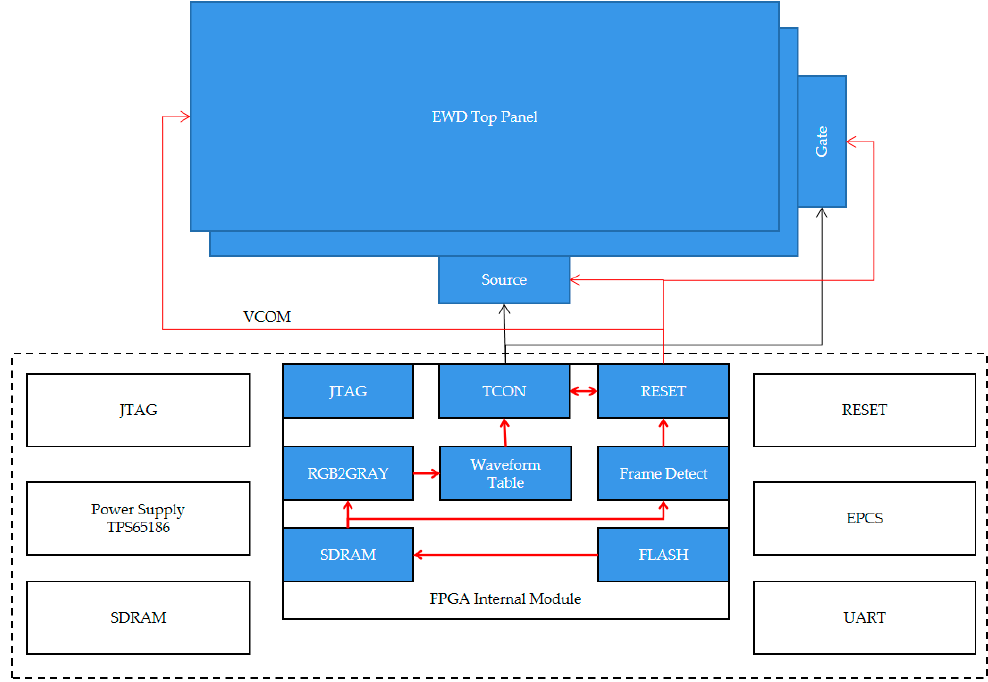
Figure 5. The block diagram of the driving board and the function module of a FPGA. After the system is powered on, RGB image data are read from FLASH to SDRAM and the image data are converted into gray tone data by the RGB2GRAY module. Then, the gray tone data are used to find the waveform in the waveform table and output it to a FPGA internal module. Finally, the source and gate chips are controlled for display. Pixels can be driven by the final waveform with the control of the source and gate chips. The data frame buffer in SDRAM is detected by the frame detection module to control the dynamic output of the reset waveform.